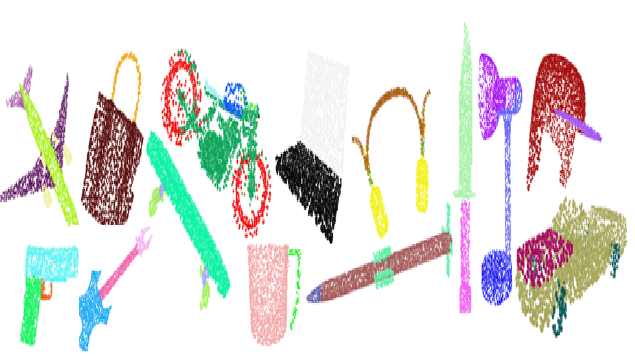
Figure 4. Qualitative analysis of part segmentation result on complete input dataset. We visualize the part segmentation result on ShapeNet part (CAD Models), having 16 different object categories. The visualization result shows that our network performs better on a benchmark